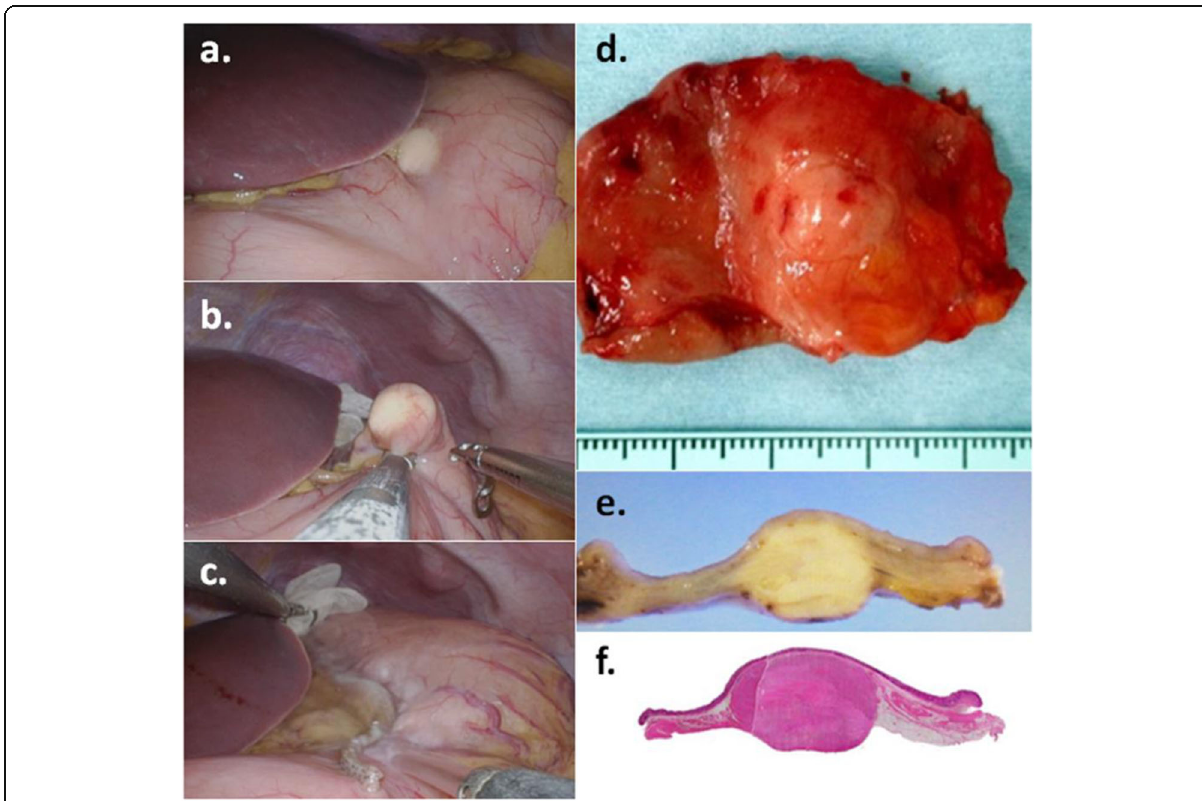
Fig. 3 The tumor could be seen at the angle of the stomach ( a ) and was resected with auto suturing device; Signia ™ Stapling System ( b , c ). The tumor was an elastic soft mass with a thin fibrous capsule and measured 15 × 15 mm in diameter ( d , e , f